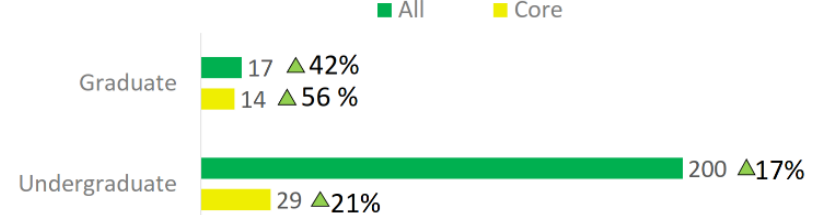
Figure 1. University of Waterloo Alternative Fuels Team (UWAFT) Graduate and undergraduate statistics. team members. Gender percentages for the team can be seen in Figure 2.